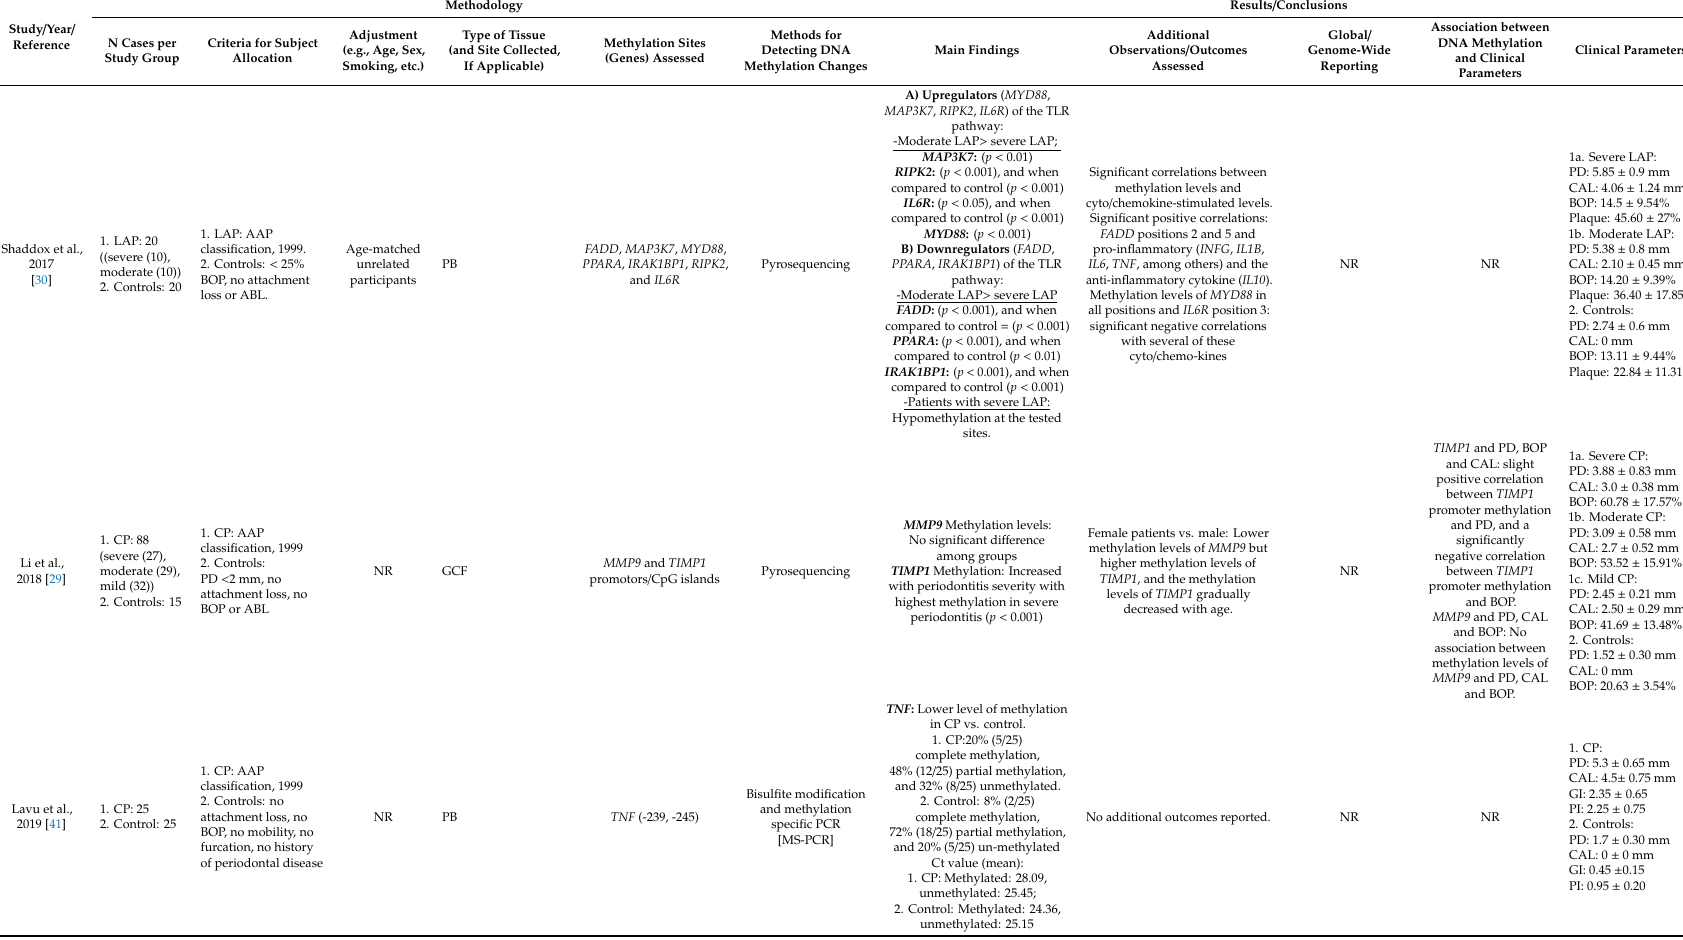
Femalepatientsvs. male: Lower methylationlevelsof MMP9 but highermethylationlevelsof TIMP1 ,andthemethylation levelsof TIMP1 gradually decreasedwithage.